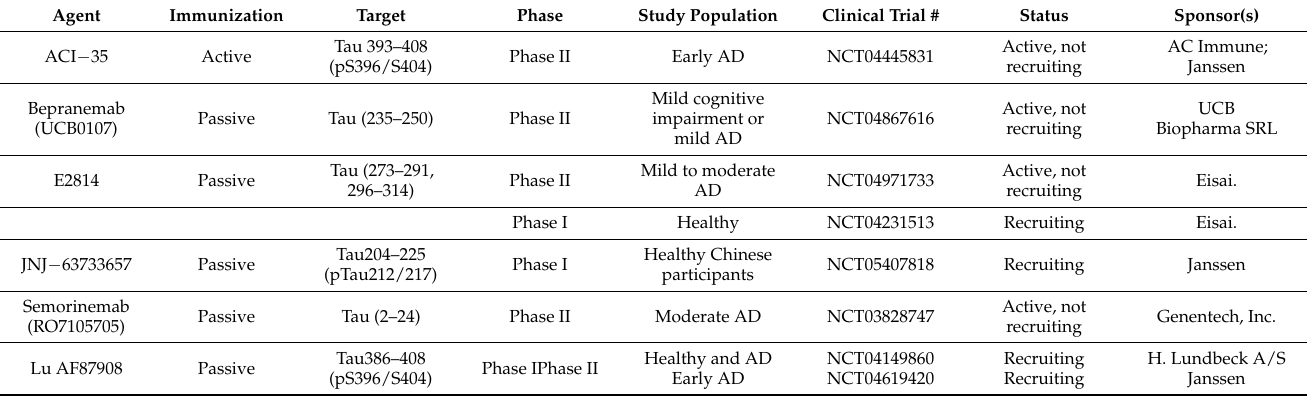
Table 2. Current ongoing clinical trials for tau immunotherapy (Clinicaltrials.gov, as of 1 October 2022).